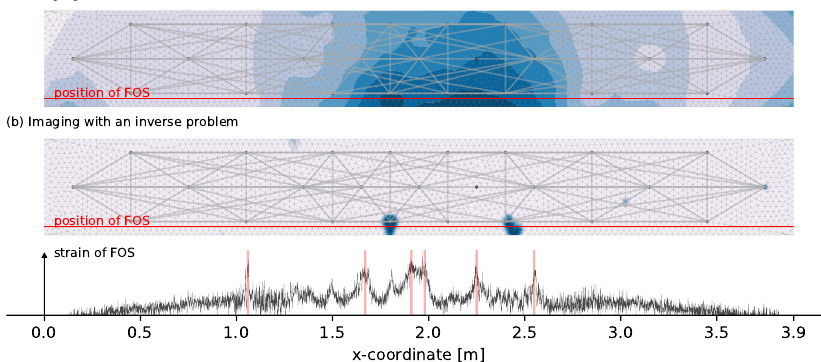
Figure 8. Evaluation at load step 4 with 20 kN load applied with the two different methods of imaging from Sections 2.4 and 2.5 shown in ( a , b